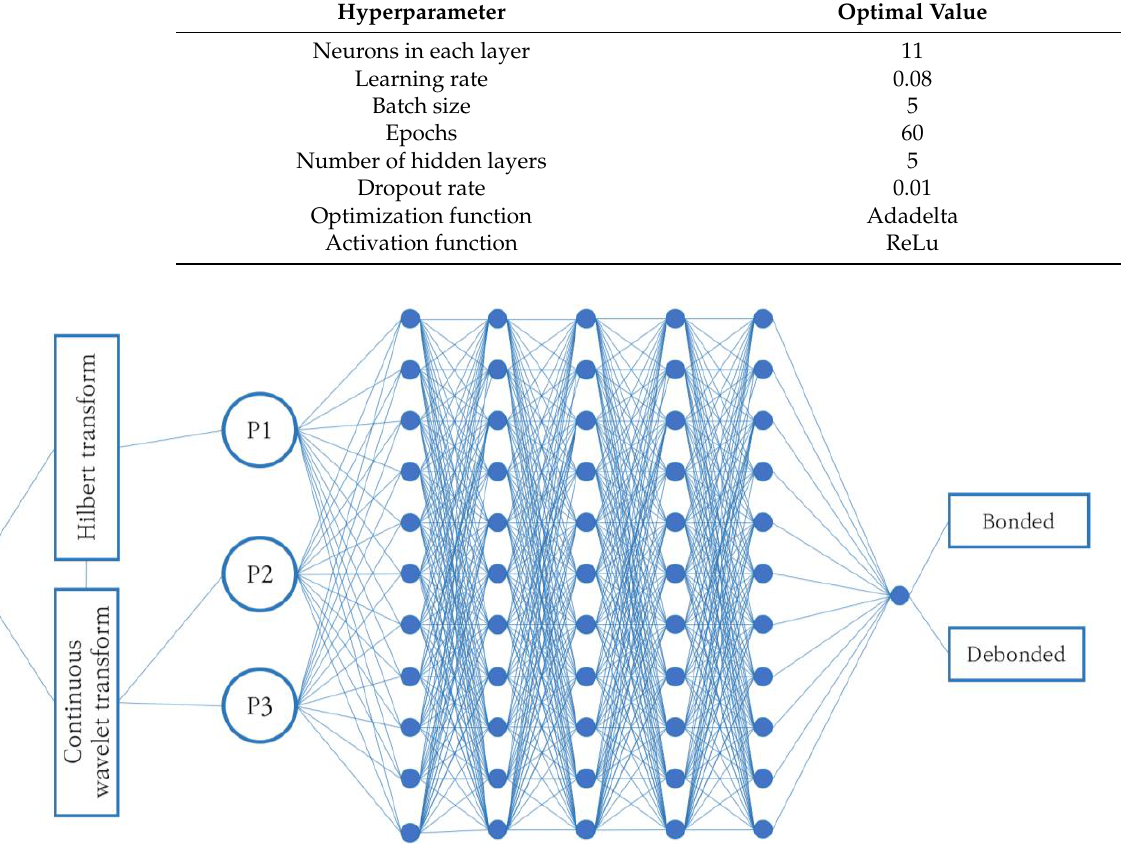
Figure 7. The DNN structure for the automatic classification of the bonding condition of the coating layer.